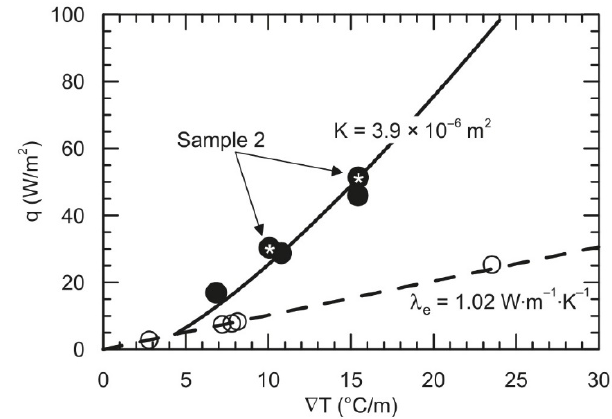
Figure 15. Experiment relationships between heat flux (q) and temperature gradient ( ∇ T) for material with d 10 of 0.15 m (Côté et al., 2011 [6]).